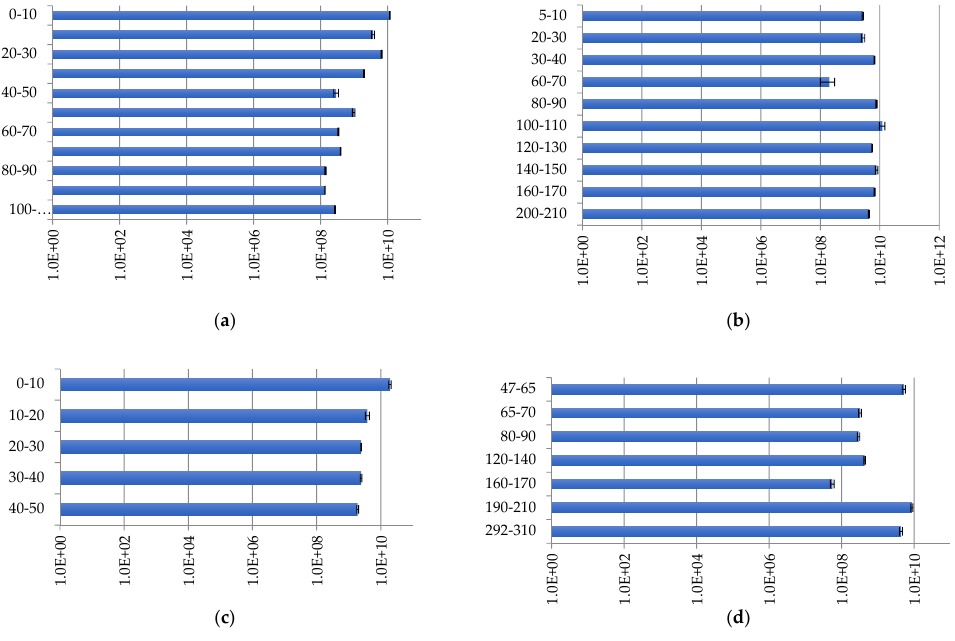
Figure 3. Bacterial distribution (copies/g of soil) in peat strata: ( a ) Inta 1; ( b ) Kolva; ( c ) Inta 11; and ( d ) Voda-Ty. At site Inta 1, the maximum numbers of bacteria were recorded in the upper peat layers (Figure 3a). The maximum number of bacterial gene copies is 1.16 × 10 10 ± 3.43 × 10 8 copies/g of soil at a depth of 0 – 10 cm, and the minimum number is 1.34 × 10 8 ± 9.23 × 10 5 copies/g of soil at a depth of 90 – 100 cm. In the lower peat layers, there is no sharp decrease in the density of bacterial groups along the profile, but there is a gradual decrease in number. At site Kolva, the profile distribution of the number of bacteria has a wave-like character, with maximum values of 1.22 × 10 10 copies/g of soil at a depth of 100 – 110 cm (Figure 3b). The minimum value found at a 60 – 70 cm depth was 2 × 10 8 copies/g of soil. The analysis of the obtained data showed a similarity between sites Inta 11 and Inta